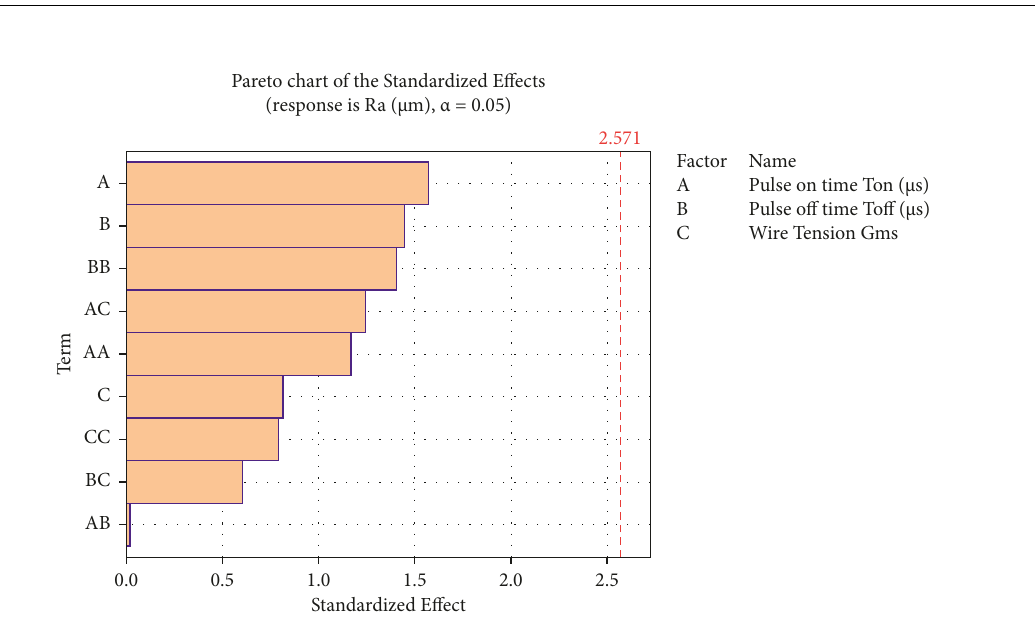
Figure 4: Pareto chart -